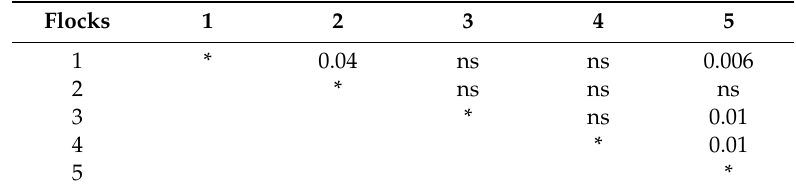
Figure 4. The number of genotypes observed ( A ) and expected ( B ) in the analysed population of Olkuska sheep. Table 3. Di ff erences in genotype distribution ( p -values) between analyzed Olkuska flocks (ns- non